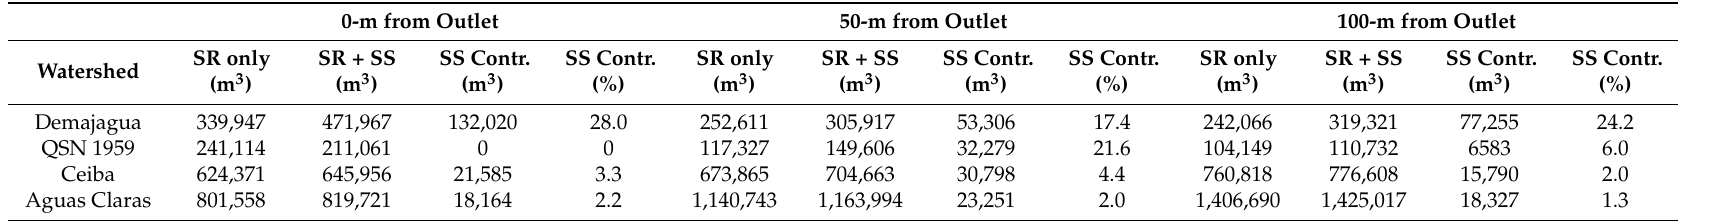
Table 6. Total volume produced by the two flooding scenarios for each watershed at different